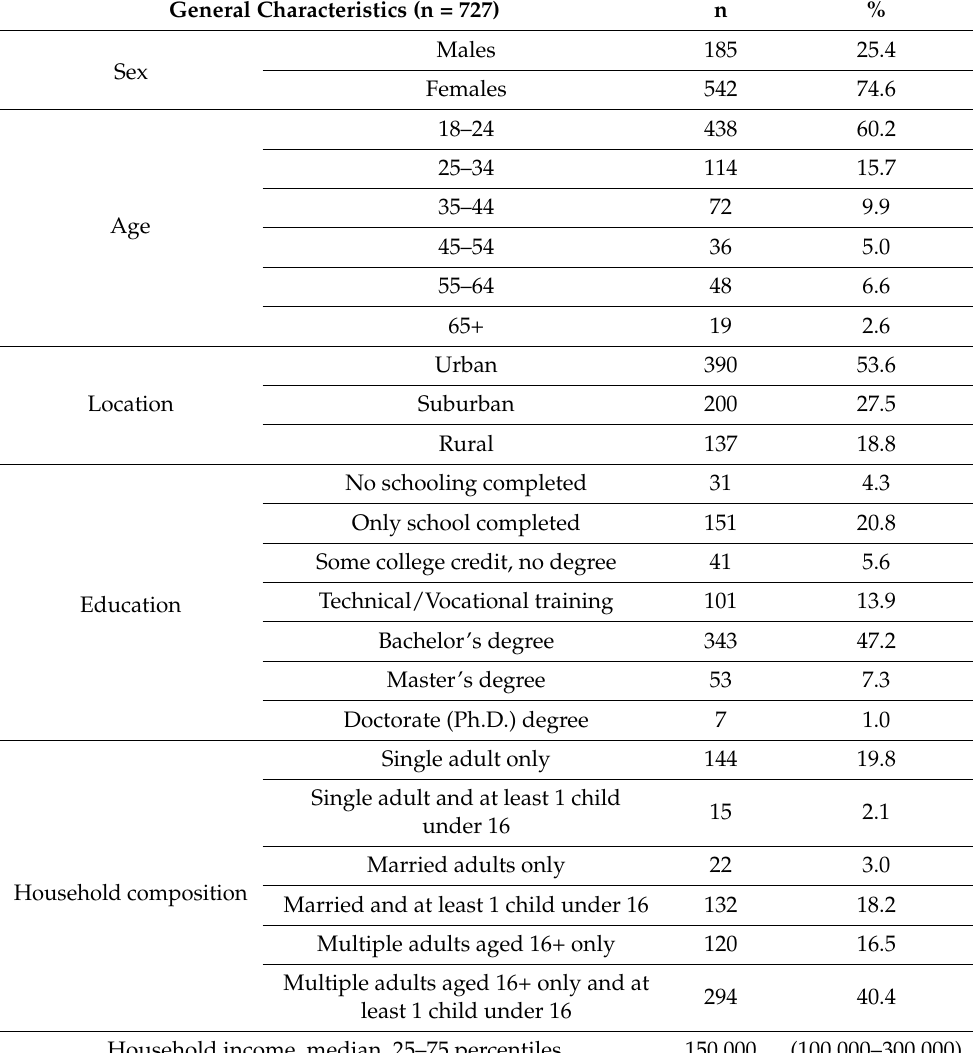
Table 1. General characteristics of the study